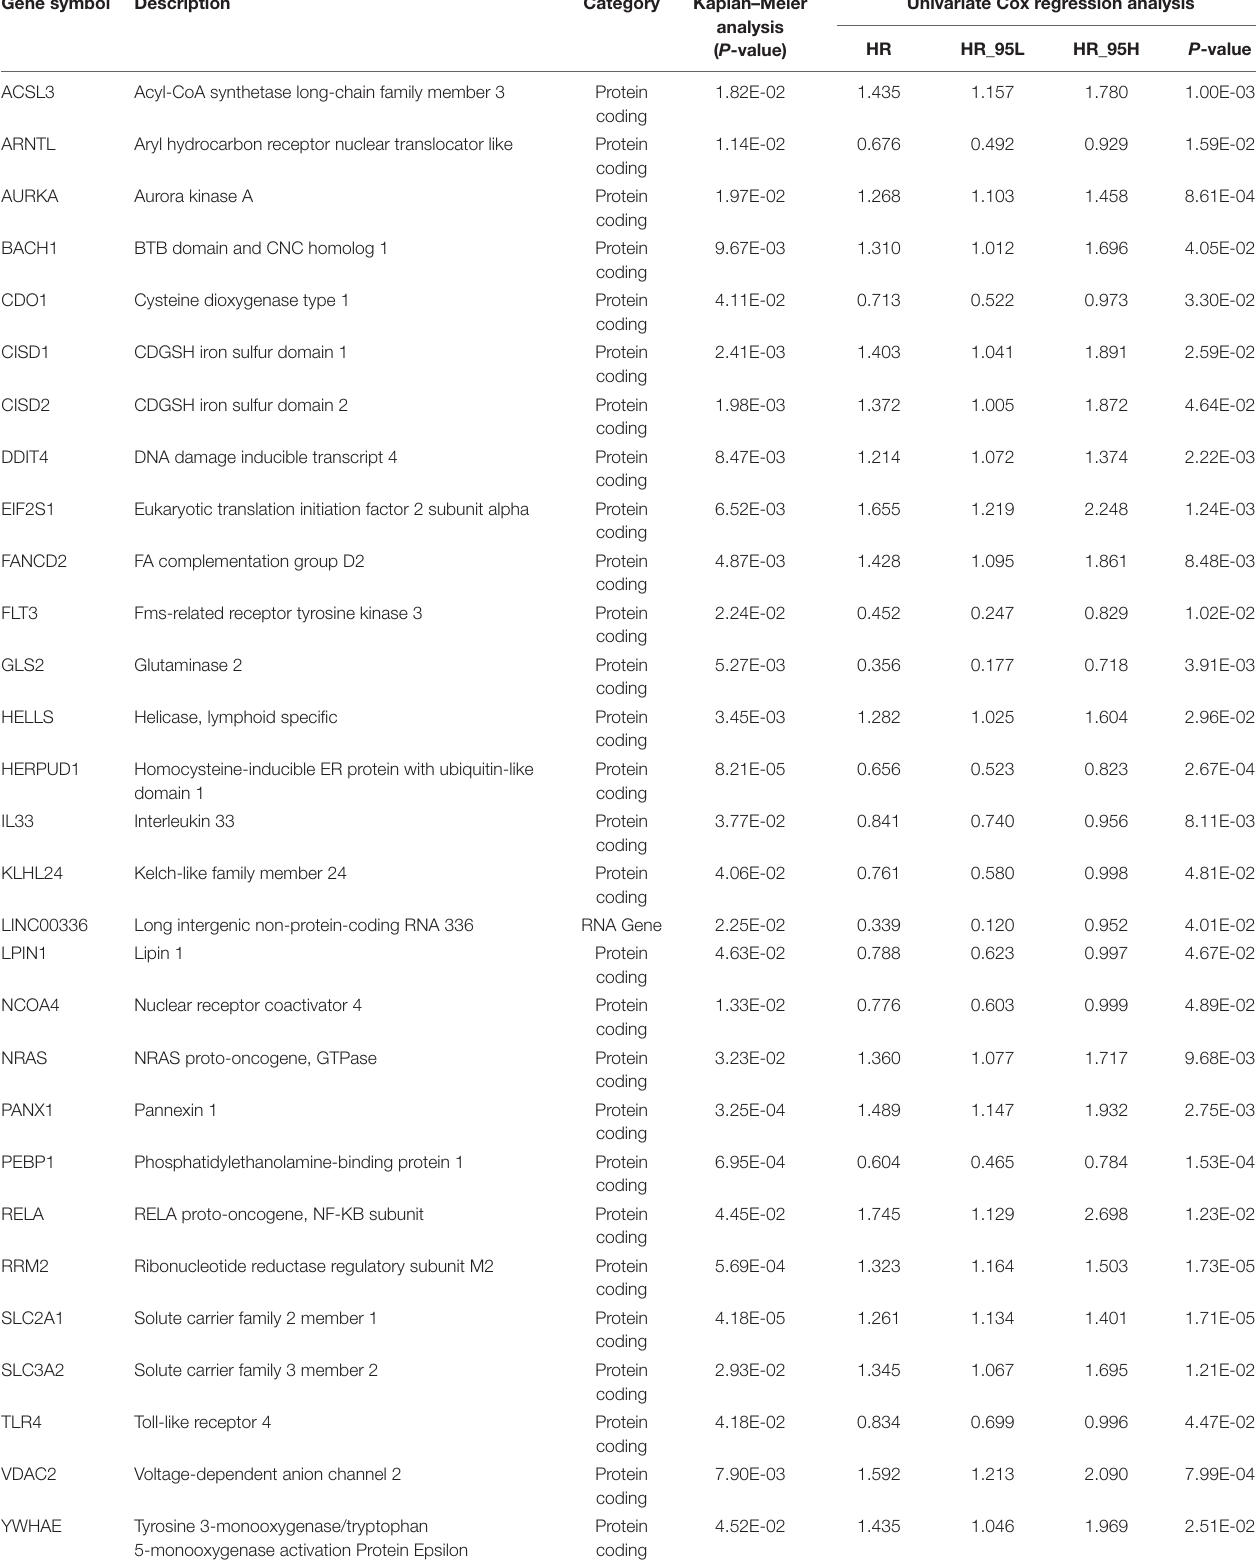
TABLE 2 | Twenty-nine ferroptosis-related potential prognostic genes generated from the training cohort. Gene symbol